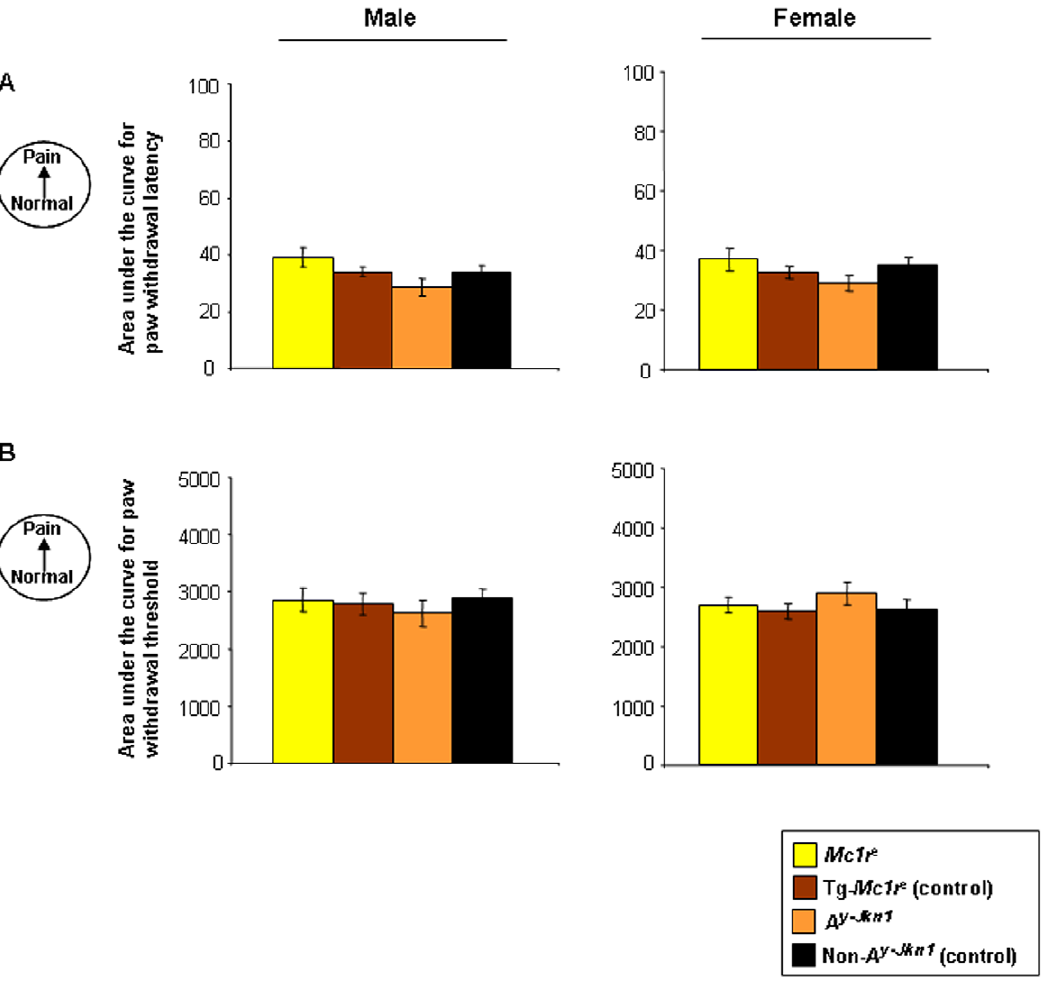
Figure 4. Behavioural analysis of CCI-induced thermal hyperalgesia and mechanical allodynia. Data represent the paw withdrawal latency [ A ], paw withdrawal threshold [ B ] as measures of thermal hyperalgesia and mechanical allodynia respectively in male and female Mc1r e , Tg- Mc1r e , A y-Jkn1 and control non- A y-Jkn1 adult mice, prior to- and post-surgery shown as the area under the curve (AUC; which measures the total change over the time course (baseline to post-surgery day 21) of CCI-induced thermal hyperalgesia and mechanical allodynia; n=5–6 per genotype). AUC’s were calculated from raw data by the standard trapezoidal rule. No significant differences in either male or female mice were observed.